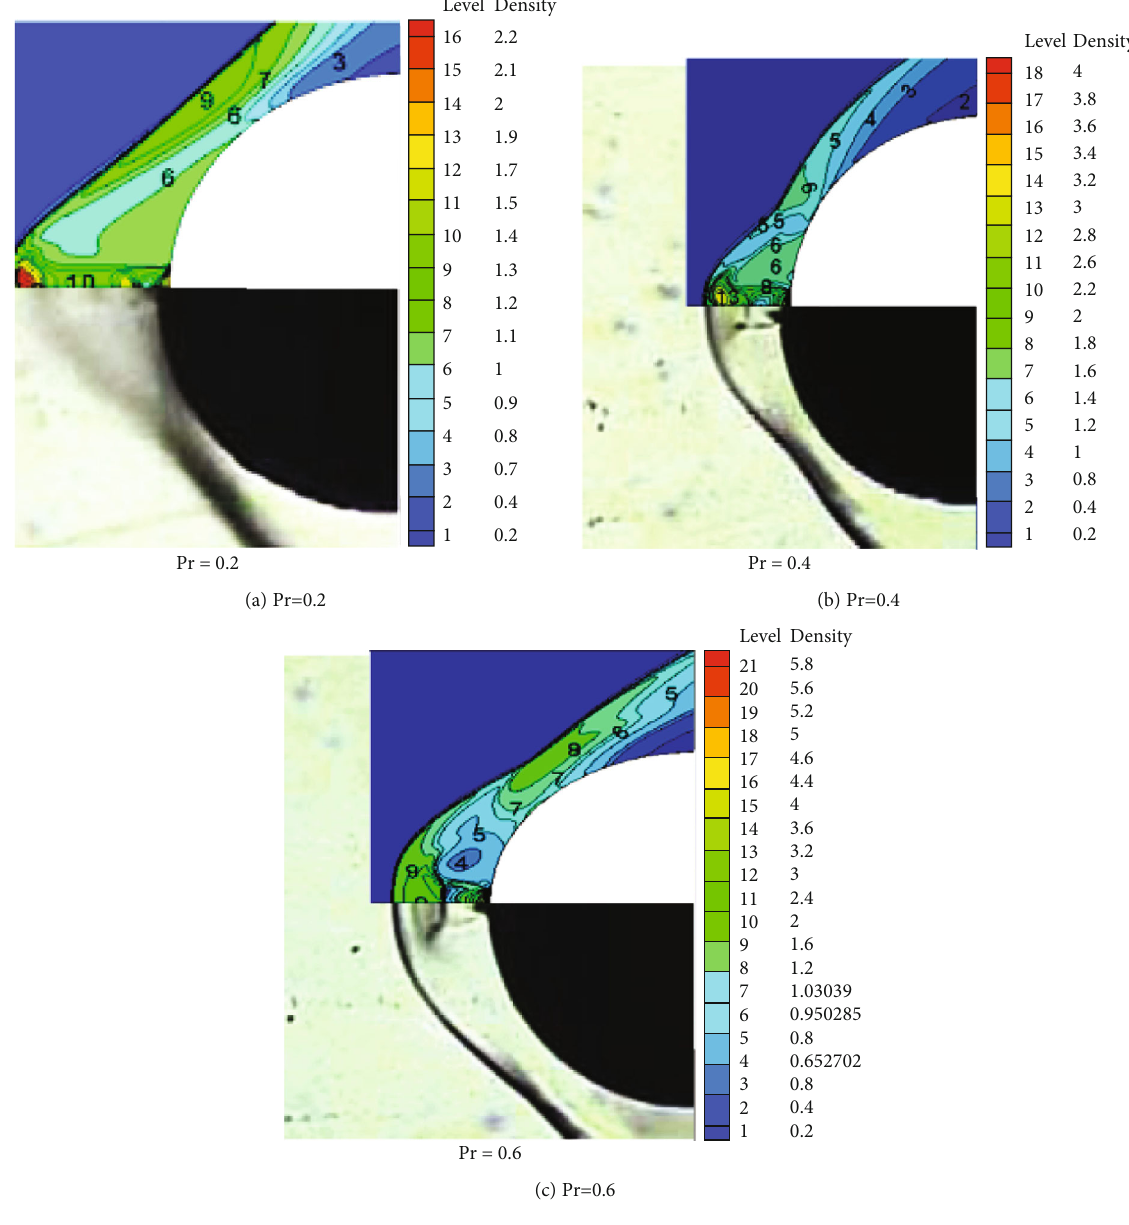
Figure 5: Comparison of simulation and experimental